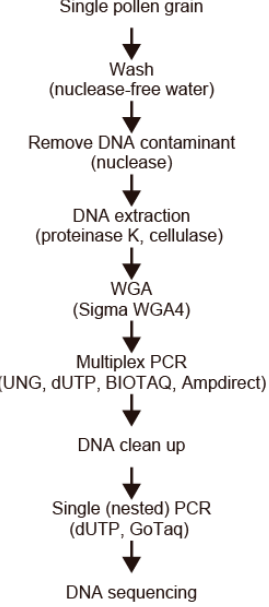
Figure 2. Flow chart of the experimental